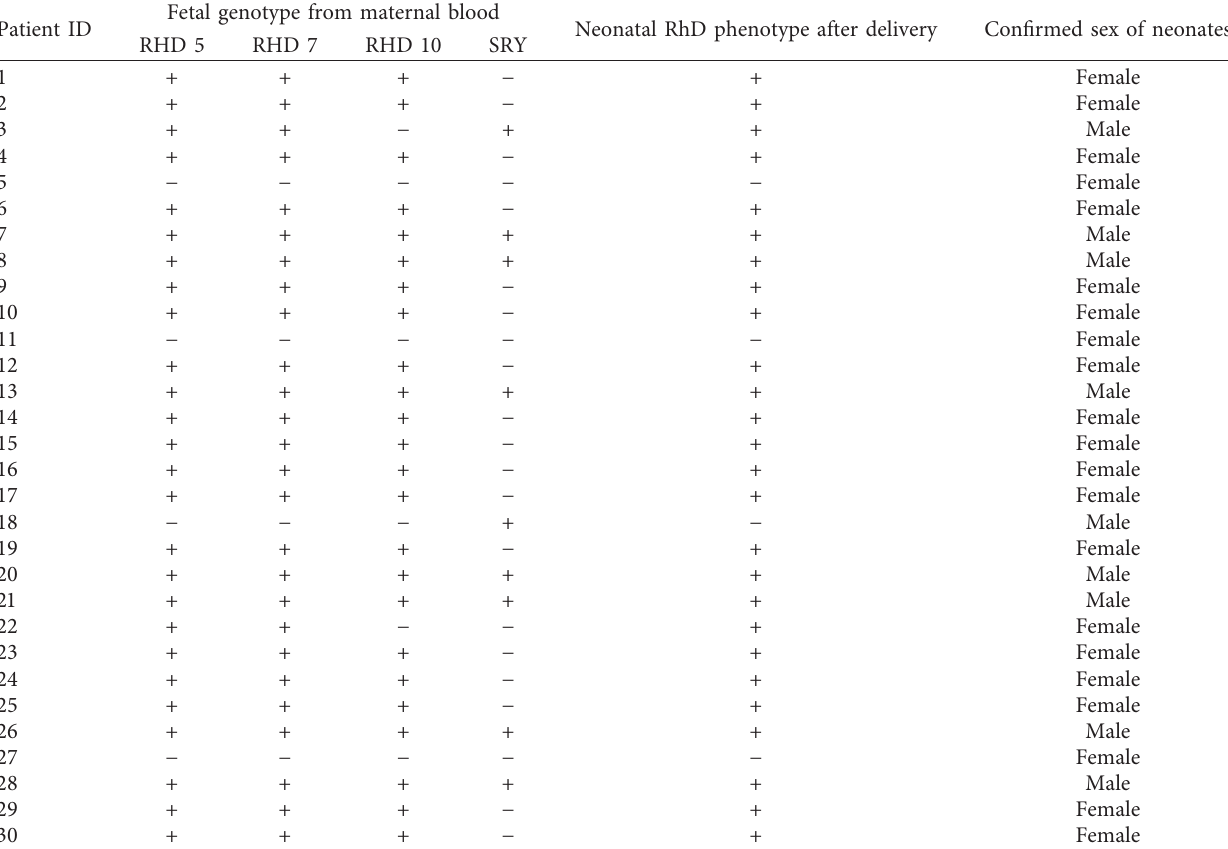
Table 2: Fetal sex, RhD genotype from maternal plasma, and their confirmation after delivery. Patient ID